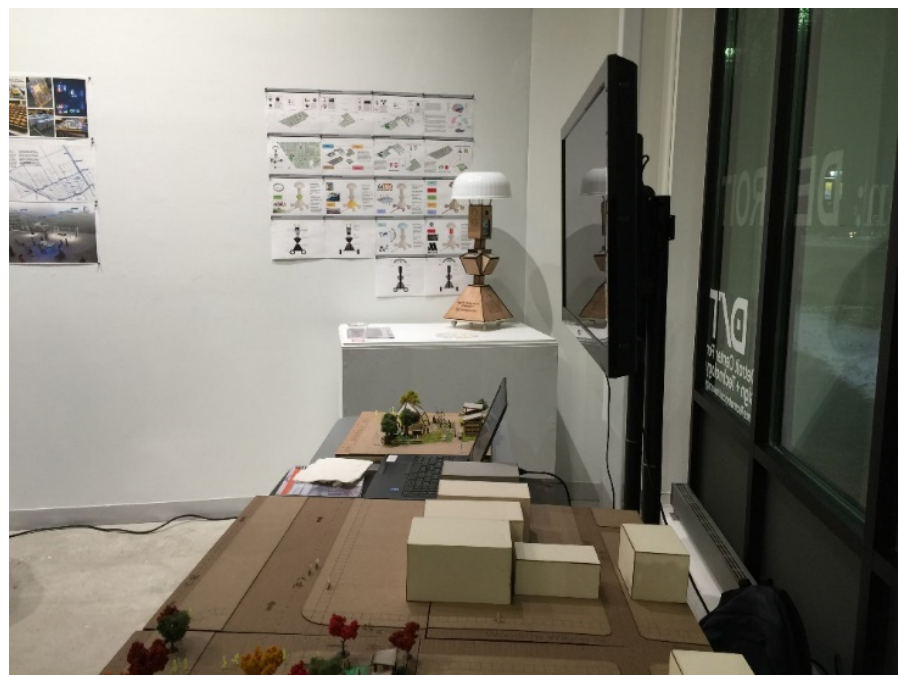
Figure 12. An example of simulation (proof-of-concept models were developed prior to designing and building a full-scale MMS). and building a full-scale